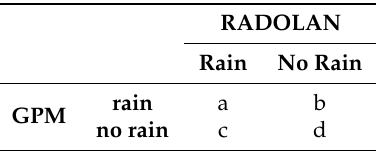
Table 1. Contingency table for the calculation of categorical indices.